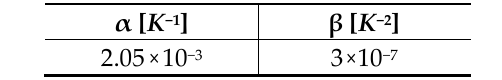
Table 1. Temperature coefficient of the metal layer.